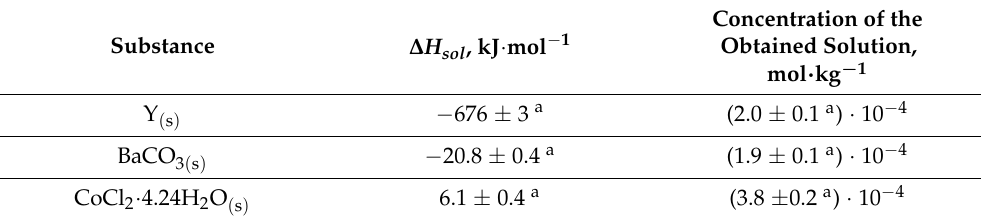
Table 3. The experimental enthalpies of solution of Y, BaCO 3 and CoCl 2 · 4.24H 2 O in 4 mol · dm − 3 HCl with addition of N 2 H 6 Cl 2 at 298.15 K, ∆ H sol .